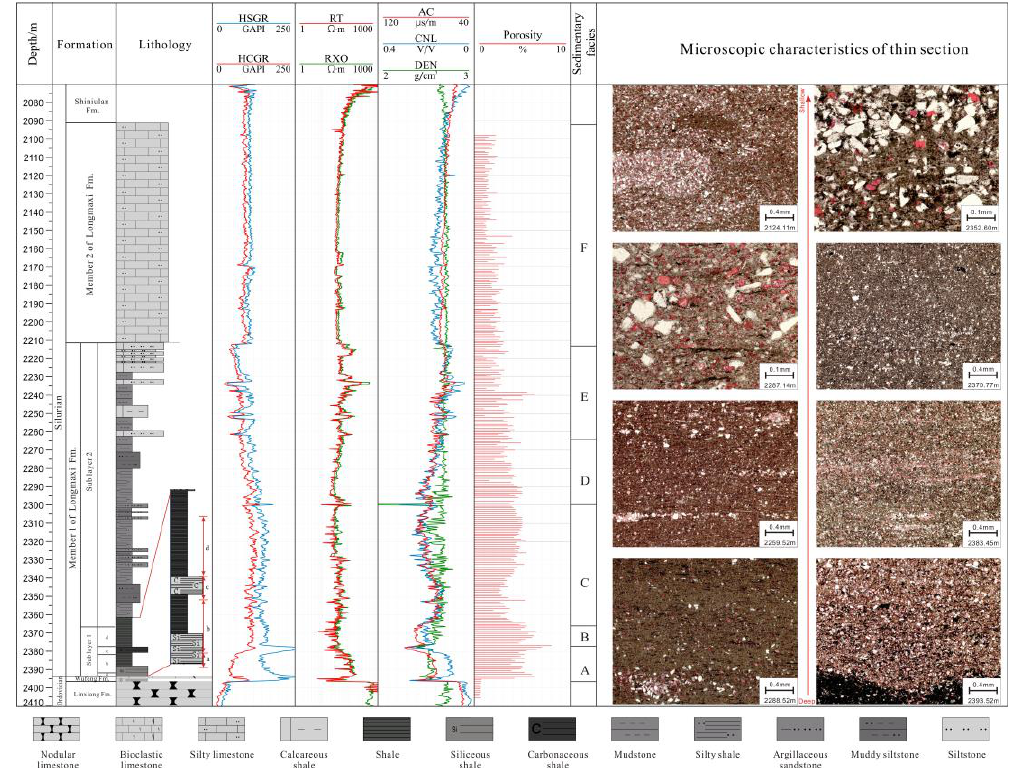
Figure 7. Comprehensive section of sedimentary facies and microscopic characteristics of the Longmaxi Formation in well N3.